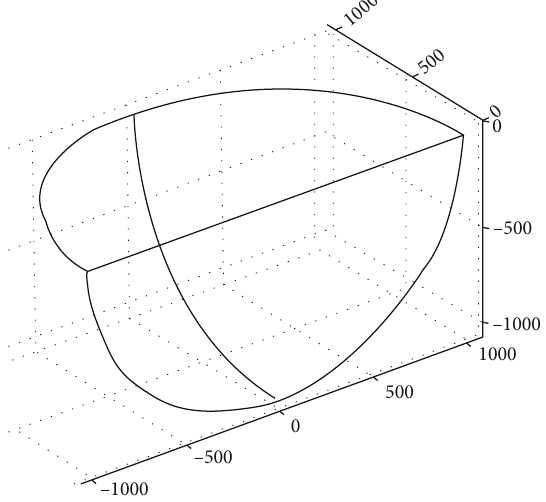
Figure 3: Simulated volume constructed in the COMSOL Multiphysics program